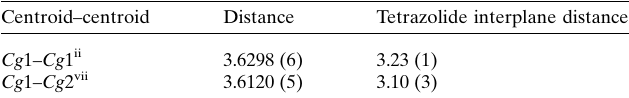
Table 3 (cid:2) – (cid:2) stacking interaction lengths (A˚ ). Cg 1 and Cg 2 are the centroids of the C1/N1/N2/N3/N4 and C2–C6/N5 rings, respectively. Centroid–centroid